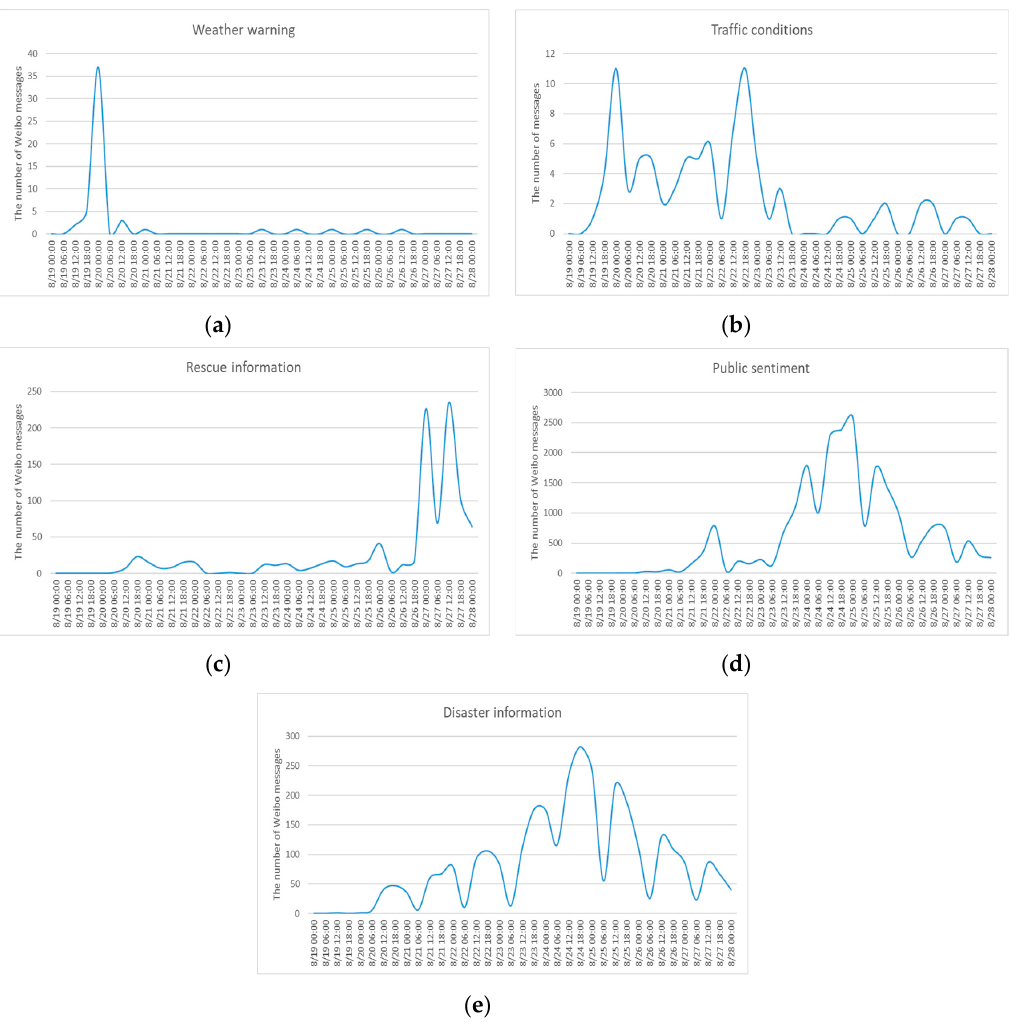
Figure 6. The trend of Weibo expressing different topics over time. ( a ) weather warning, ( b ) traffic conditions, ( c ) rescue information, ( d ) public sentiment, ( e ) disaster information.